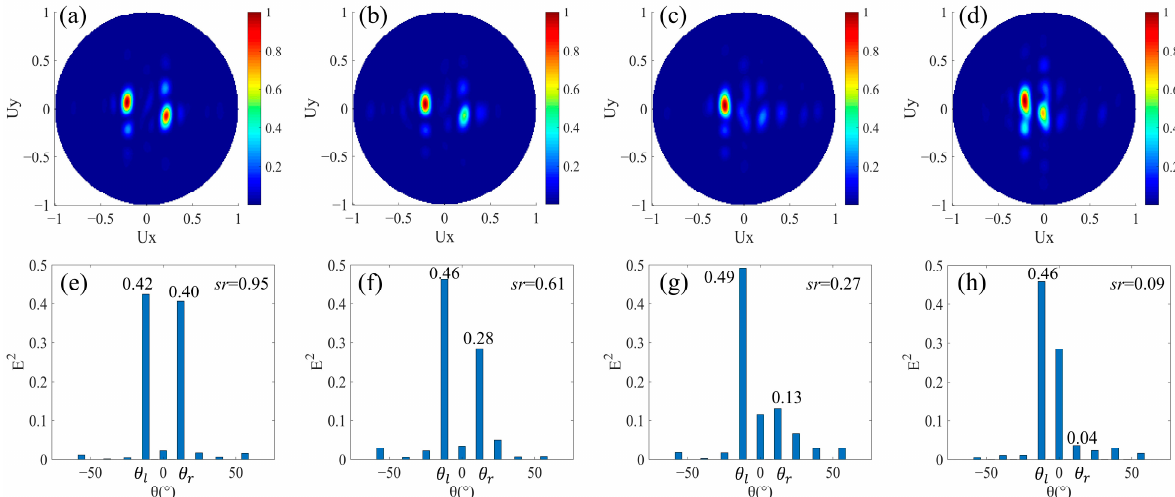
Figure 4. Simulation results of beam splitters with same split angle and different split energies. N l = N r + M , M ≠ 0. The normalized far-field projection intensity distributions of designs ( a ) N l = 7, M = 1, ( b ) N l = 7, M = 2, ( c ) N l = 7, M = 3, and ( d ) N l = 7, M = 4, respectively. ( e – h ) are the normalized field intensity under the main split angle corresponding to the results of ( a – d ) respectively.